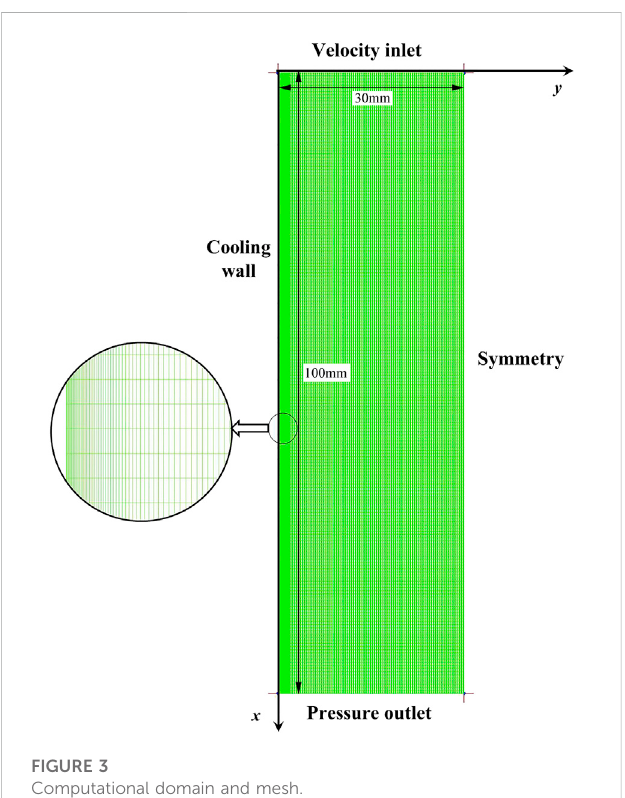
FIGURE 3 Computational domain and